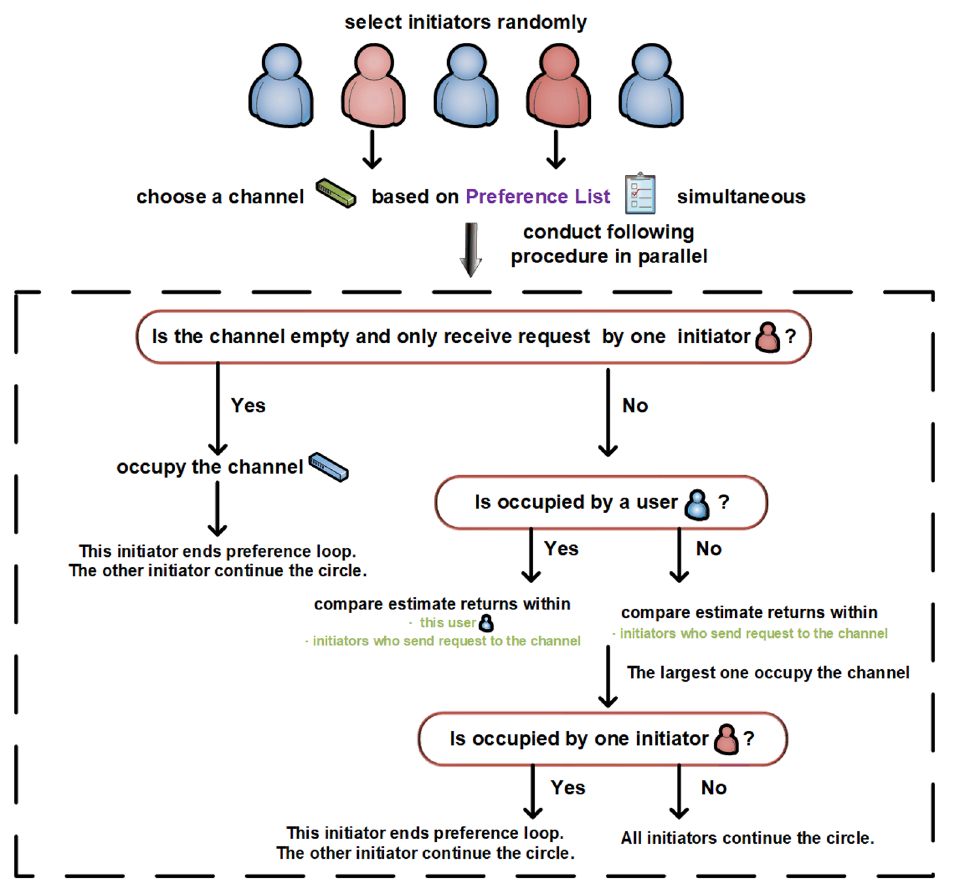
Figure 6. Exchange steps with SCA as the target